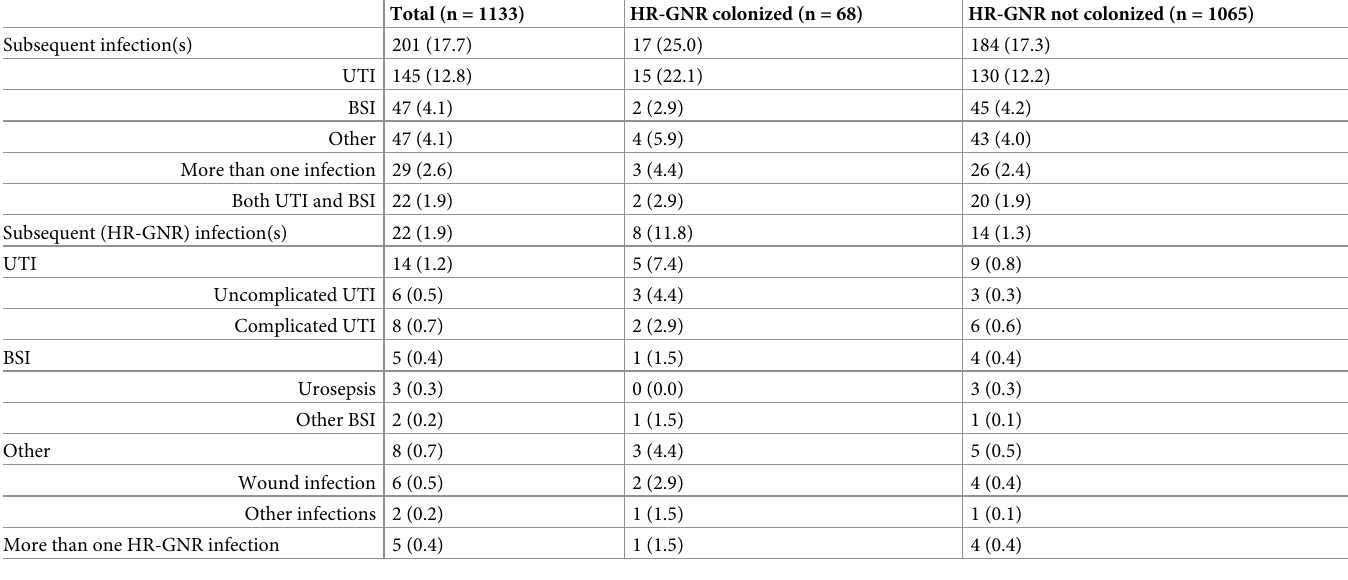
Table 2. Descriptive subsequent (HR-GNR) infection(s) of the